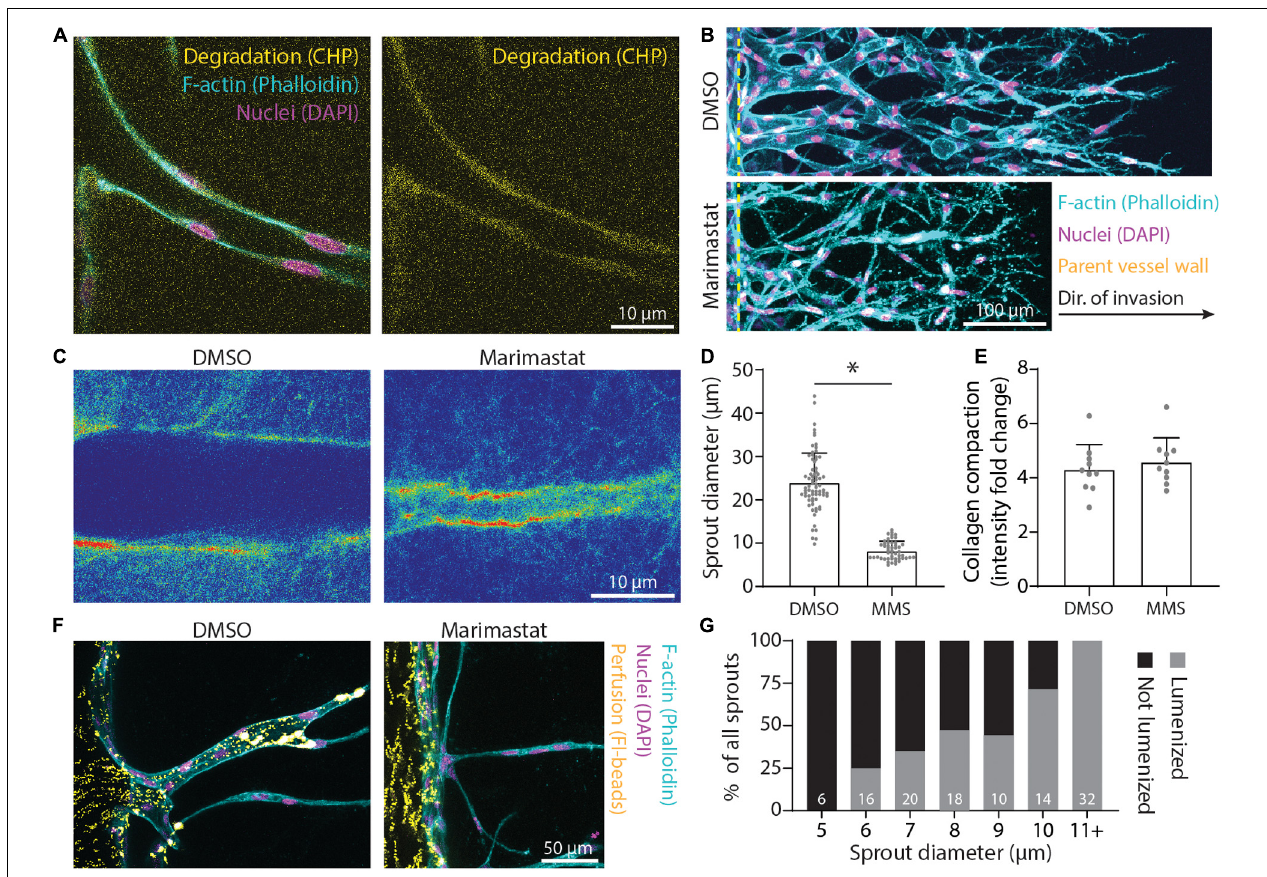
FIGURE 7 | Matrix proteolysis is required for larger sprout diameters that are lumenized. (A) Representative image (individual z -slices) of collagen degradation along sprout stalk cells. F -actin (cyan), nuclei (magenta), collagen hybridization peptide (CHP; yellow). (B) Representative images (max intensity projections) of marimastat (MMS) treatment (1 µ M) of sprouts cultured over 5 days with 250 nM sphingosine 1-phosphate (S1P) and 25 ng ml − 1 phorbol 12-myristate 13-acetate (PMA) within 3 mg ml − 1 collagen. (C) Representative images (single z-slice) of fluorescently labeled collagen (intensity heat map) with MMS treatment (1 µ M) of sprouts cultured over 3 days with 250 nM S1P and 25 ng ml − 1 PMA within 3 mg ml − 1 collagen. (D,E) Quantifications of sprout diameter and collagen compaction from MMS treatment (1 µ M). For sprout diameter: n ≥ 50 per condition and for collagen compaction: n ≥ 10 per condition. (F,G) Assessment of lumenization as a function of sprout diameter by parent vessel perfusion of 1 µ m-diameter microsphere. Sample size for total sprouts analyzed for each group is indicated in bar plot. All data presented as mean ± SD; *indicates a statistically significant comparison with P < 0.05 (two-tailed Student’s t